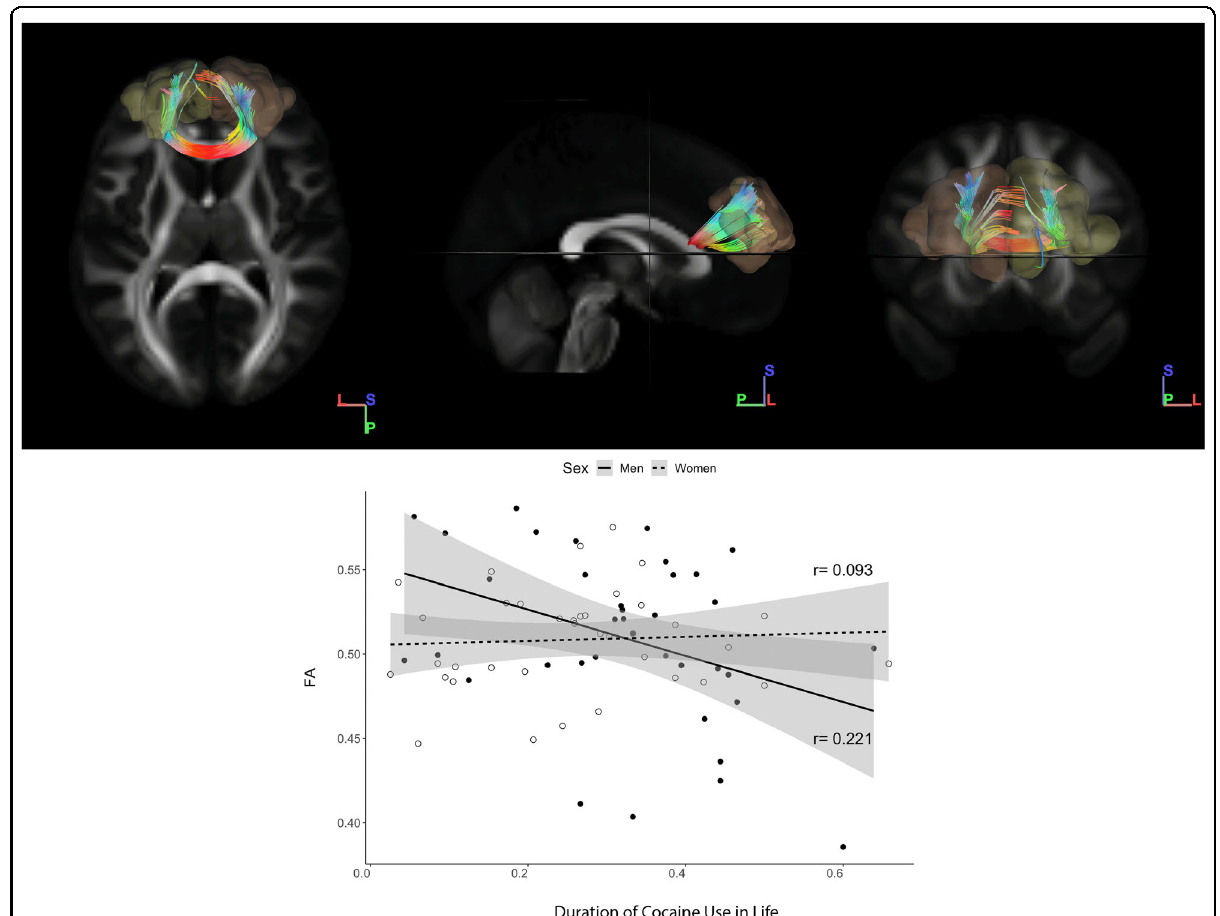
Fig. 4 White matter bundle connecting left to right BA9. Colors are respecting the direction of the fi bers. Graphs show the associations between the tract average FA and MD values with the years of cocaine use considering the interaction effect of sex. MD mean diffusion, FA fractional anisotropy, BA9 Brodmann area